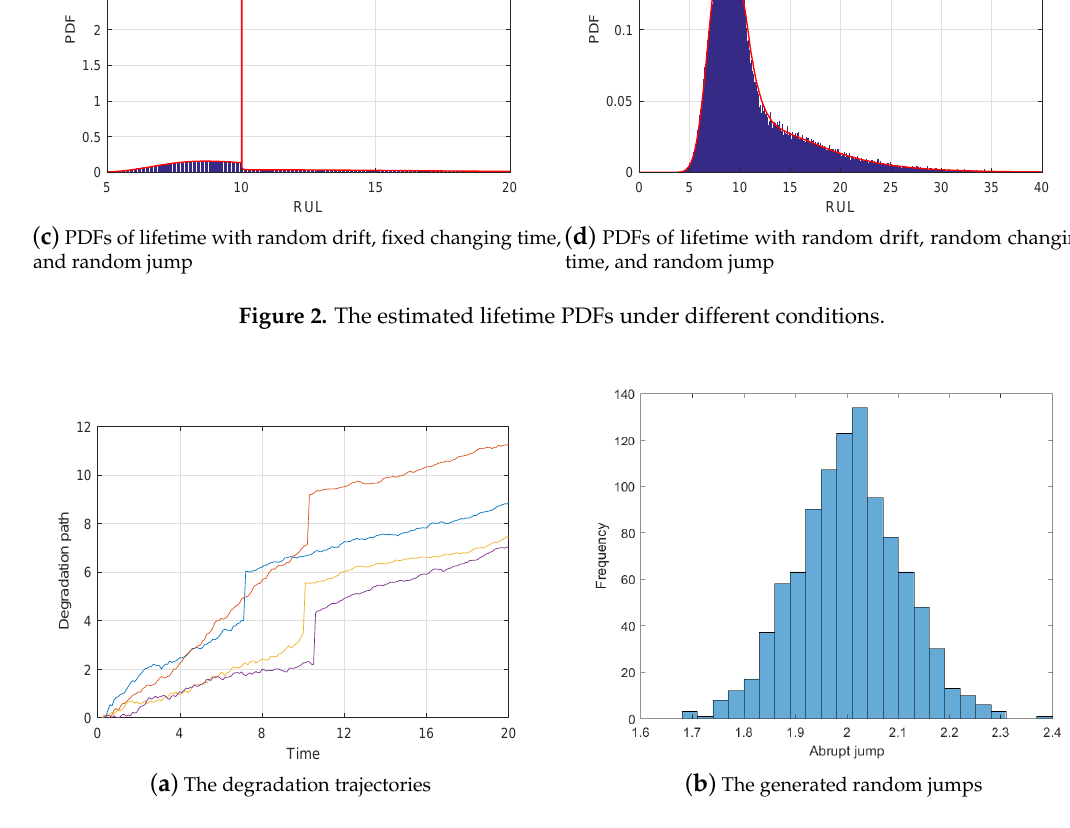
Figure 3. The examples of the simulation degradation process. Table 1. The parameters estimation with different sample